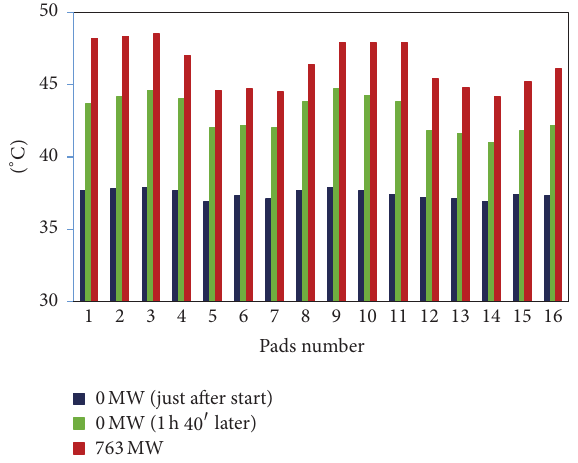
Figure13:Temperaturesofupperjournalbearingpadsat0 MWand at 763